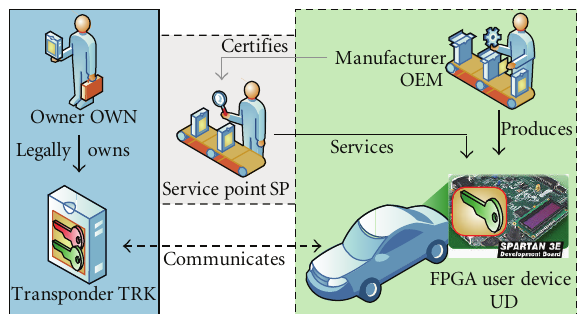
Figure 2: Entities and application